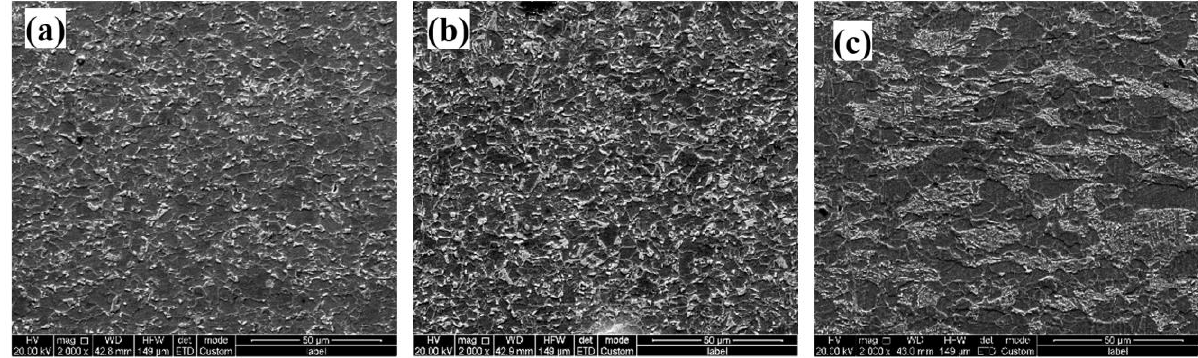
Figure 3. Microstructure of actual welded joints of 0 Nb steel: ( a ) FGHAZ; ( b ) SCHAZ; ( c ) base metal.